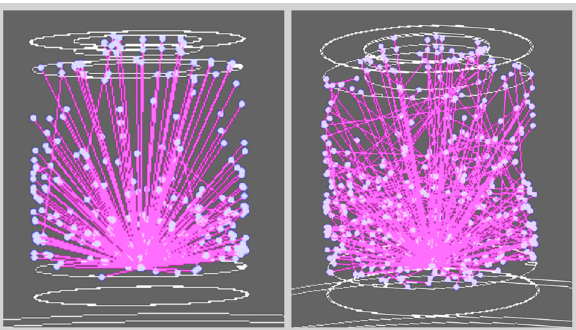
Fig. 15 Left: simulation of an α -decay in the LAr setup covered by the absorber. The α particle cannot be seen, only the VUV photons (in a reducednumber,forclarity).Right:thesamplesurfaceinthesimulation is set to Tetratex and a few photons are now reflected by its surface